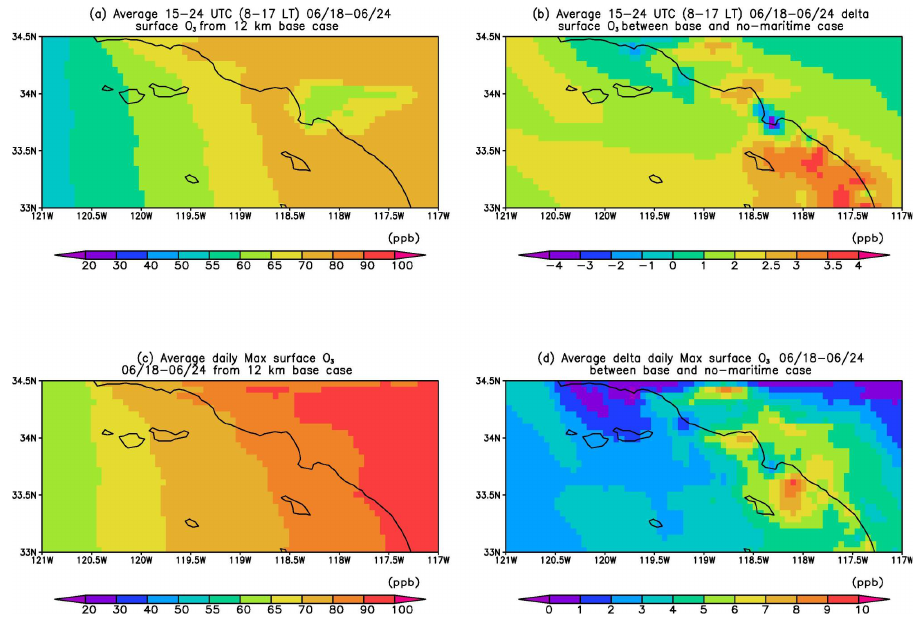
Figure 12 (a) Averaged 15-24 UTC (8-17 local time) surface O 3 from 12 km base case; (b) Averaged 15-24 UTC (8-17 local time) surface O 3 differences between 12 km base and no-maritime emission cases; (c) Average daily maximum surface O 3 from 12 km base case; (d) Average daily maximum surface O 3 differences between 12 km base and no-maritime emission cases during the flight week.